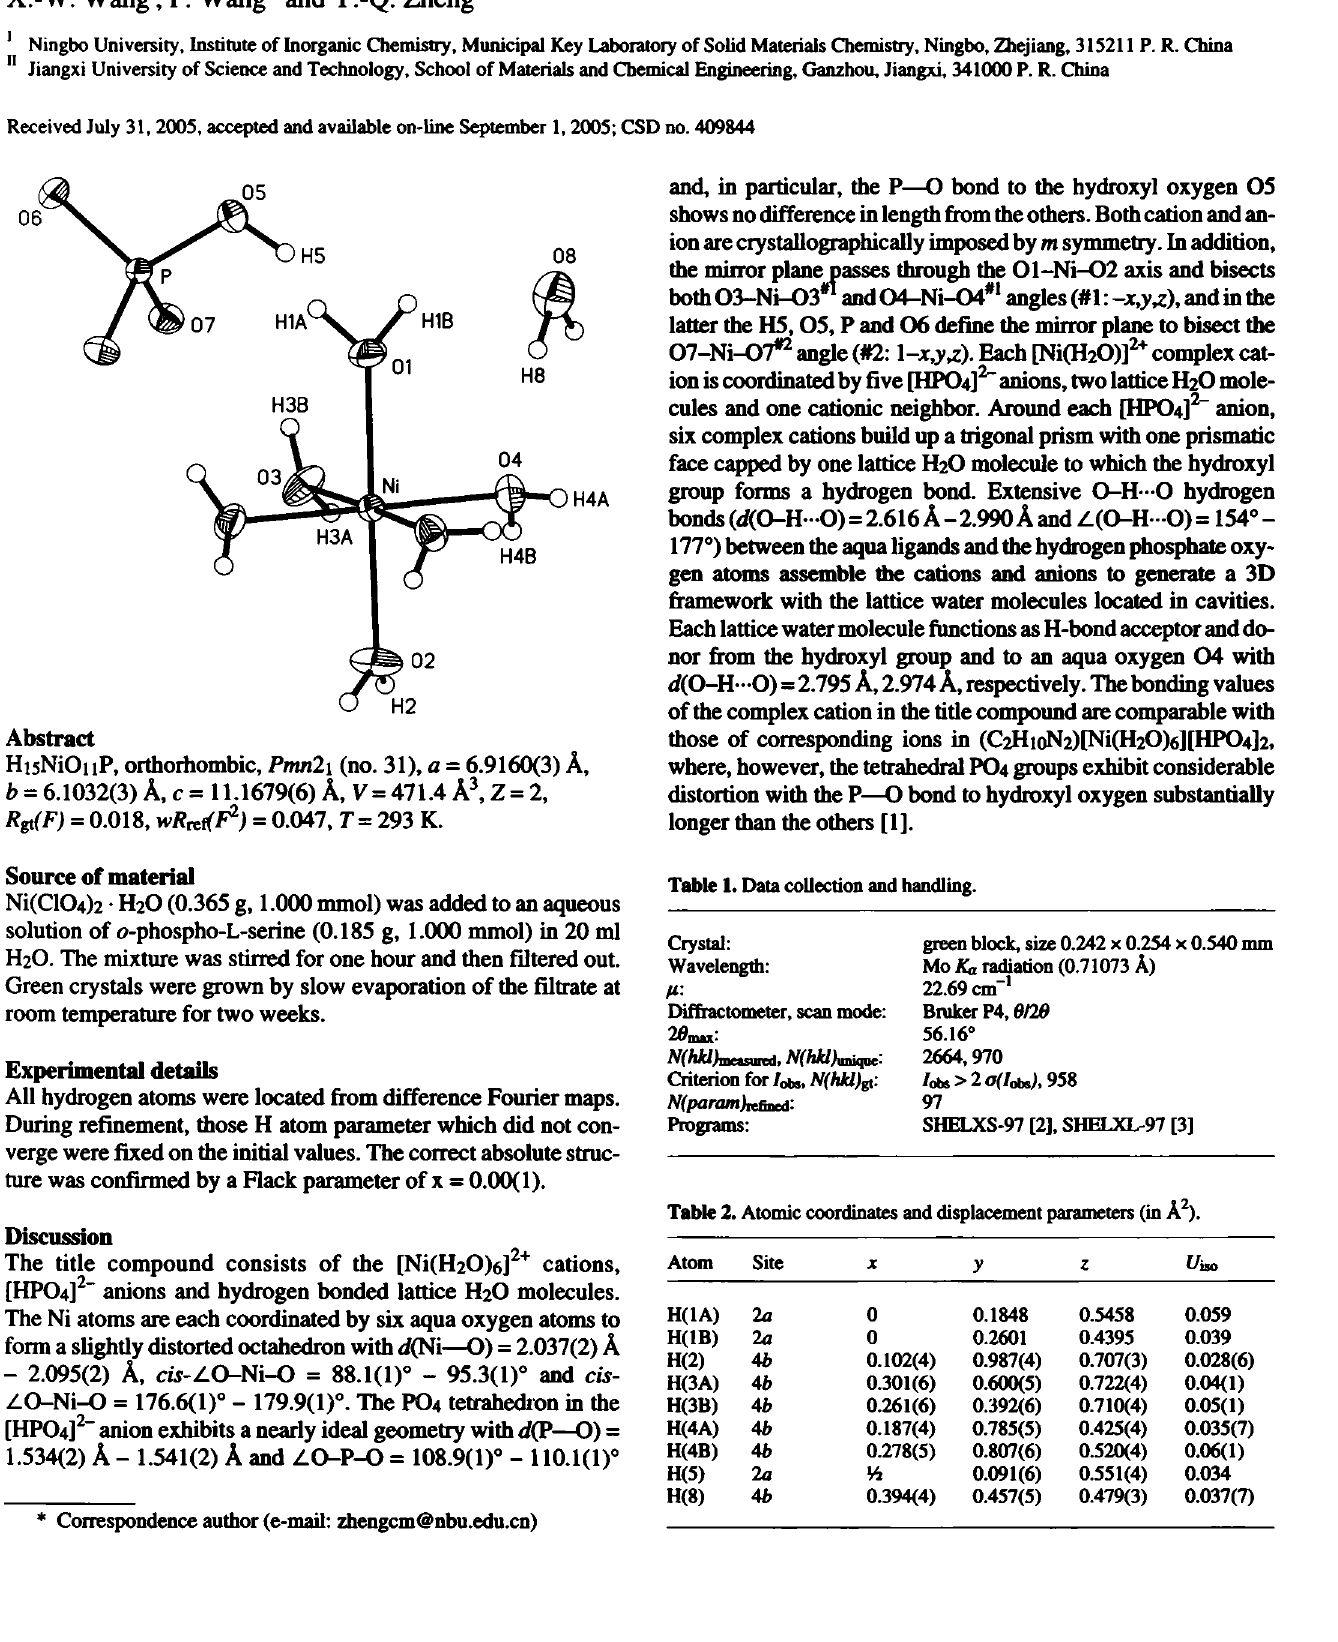
Table 2. Atomic coordinates and displacement parameters (in A 2